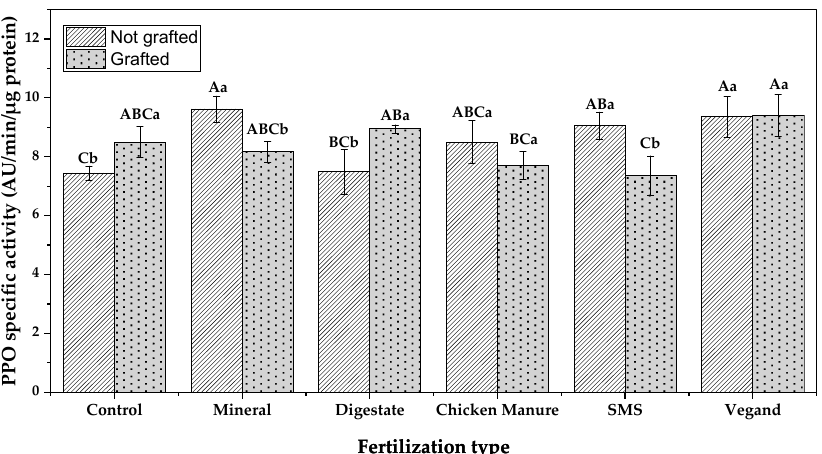
Figure 2. The specific activity of PPO in the fleshes of eggplants. Results are indicated as mean ± SD ( n = 3). A,B,C: Different capital letters show that there is a significant difference ( p ≤ 0.05) between the fertilization treatments, according to one-way ANOVA and Tukey’s honestly significant difference (HSD) tests; a,b: Different small letters show that there is a significant difference ( p ≤ 0.05) between grafted and not-grafted eggplants according to an independent t-test.